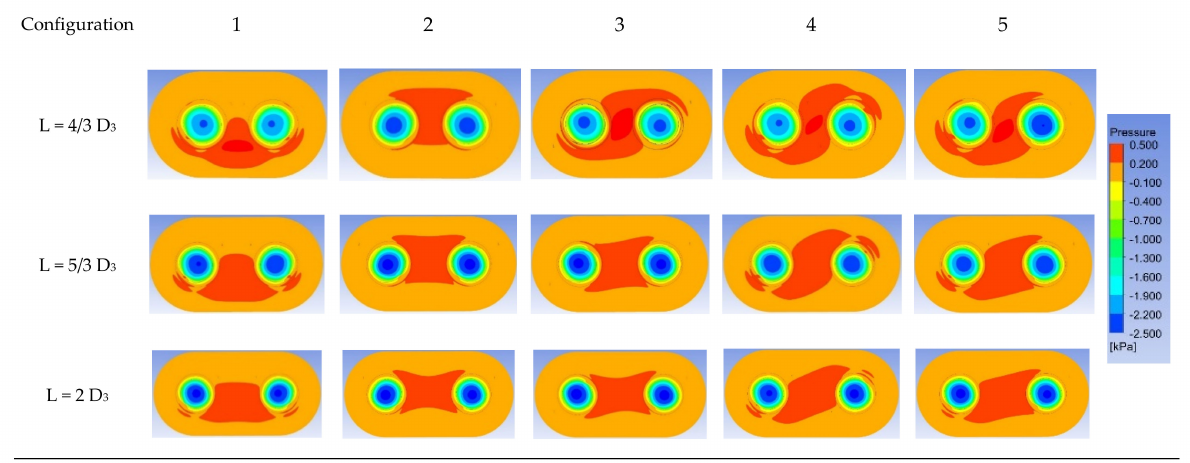
Figure 9. Pressure distribution of dual-vortex